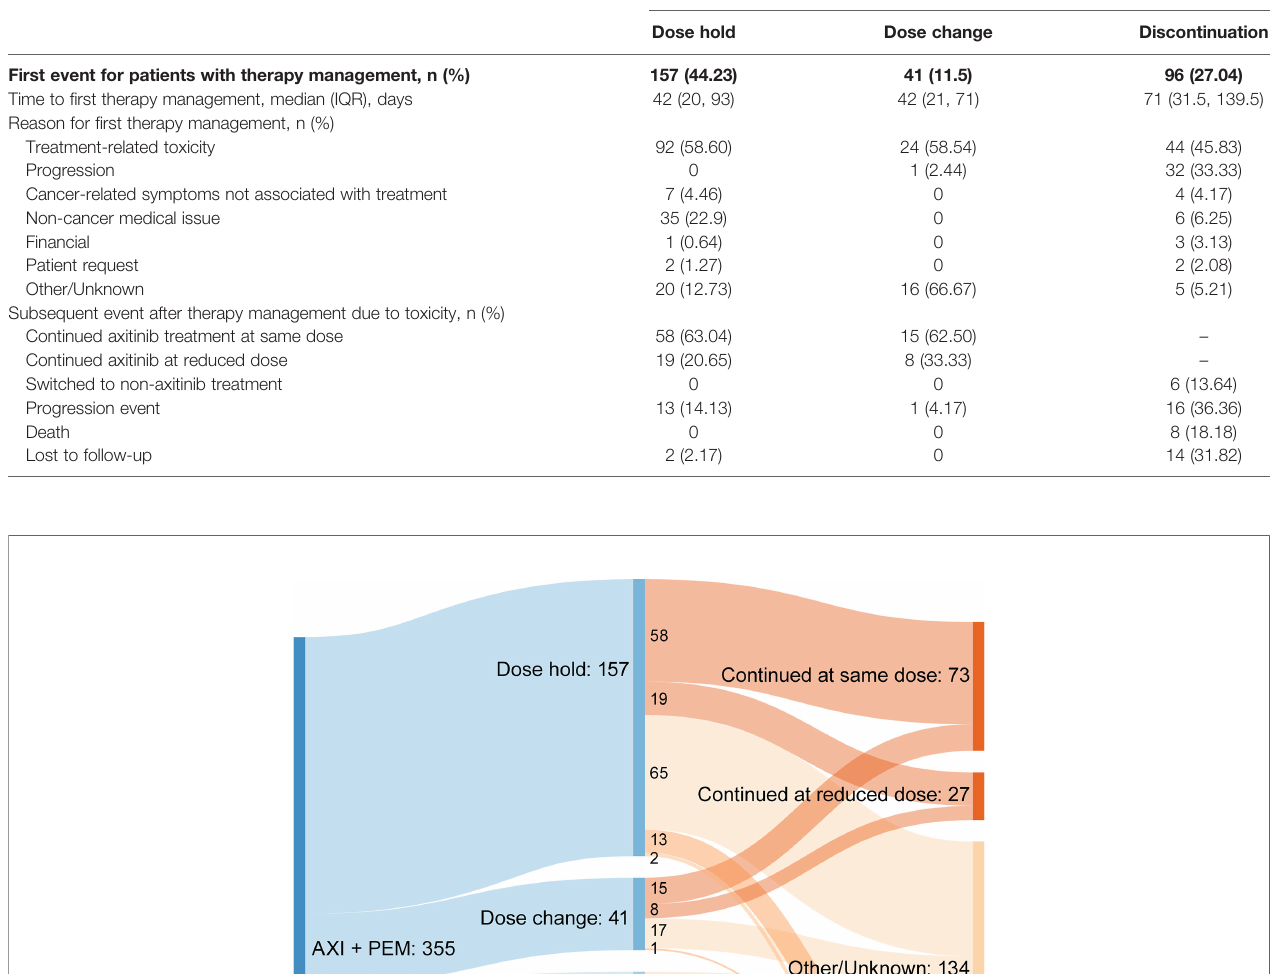
Patients with Therapy Management, n = 294